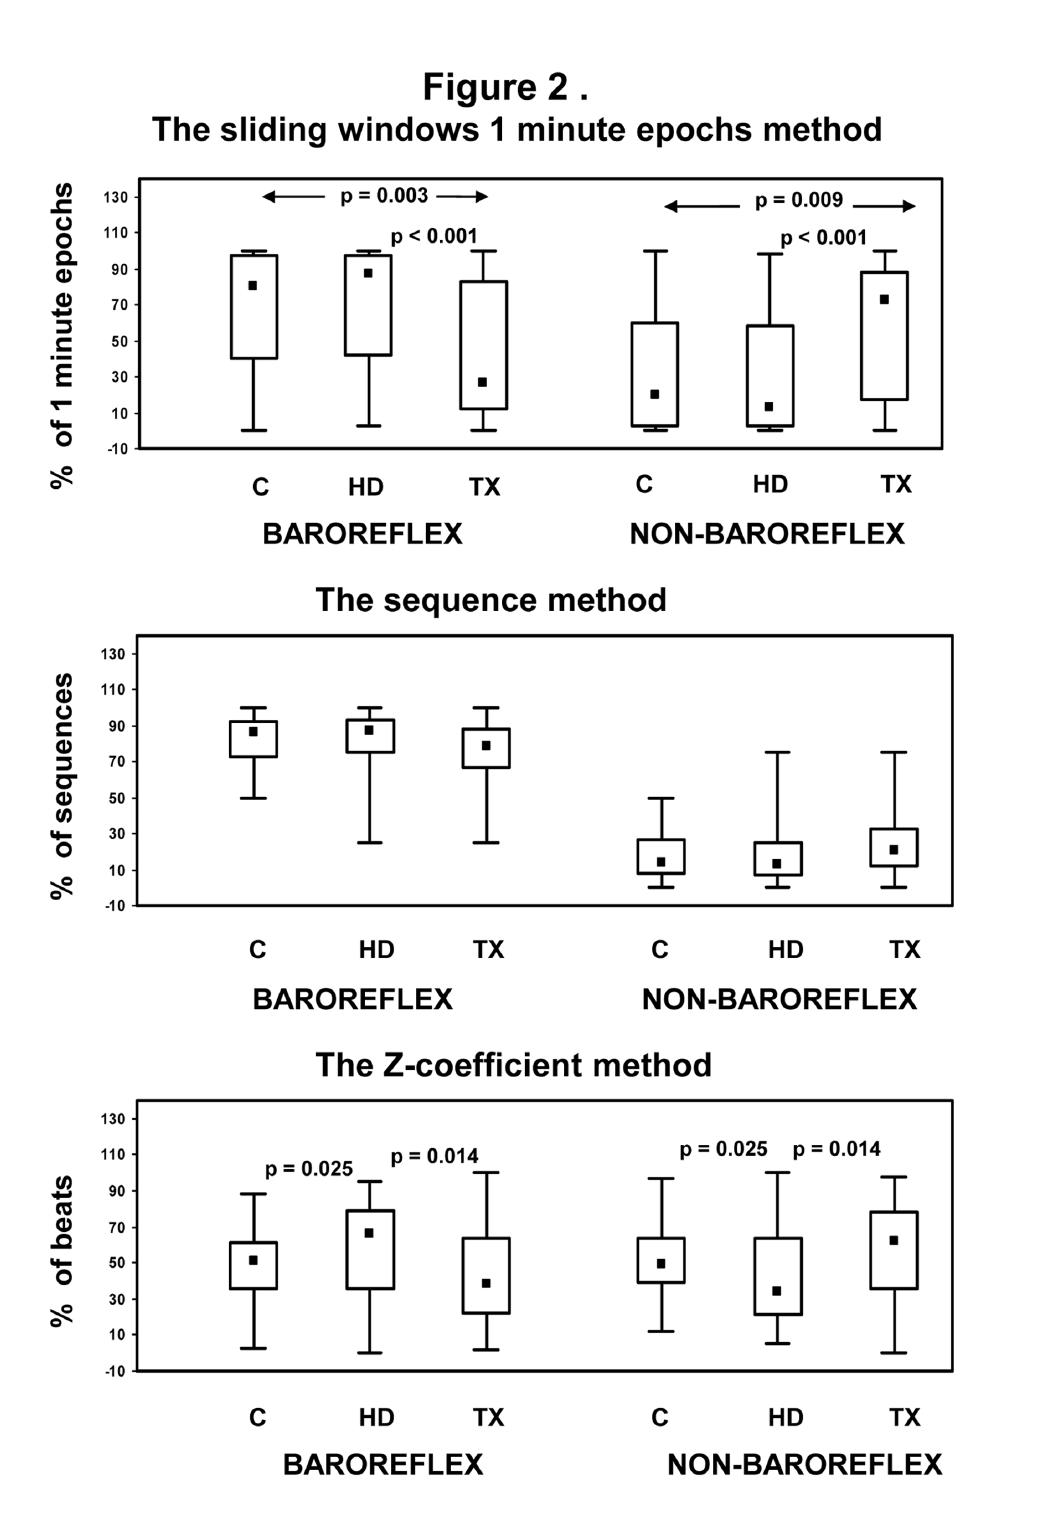
Figure 2. Distribution (%) of baroreflex and non baroreflex episodes in control (C), in hemodialysis (HD) and in transplanted (TX) patients determined by three methods.